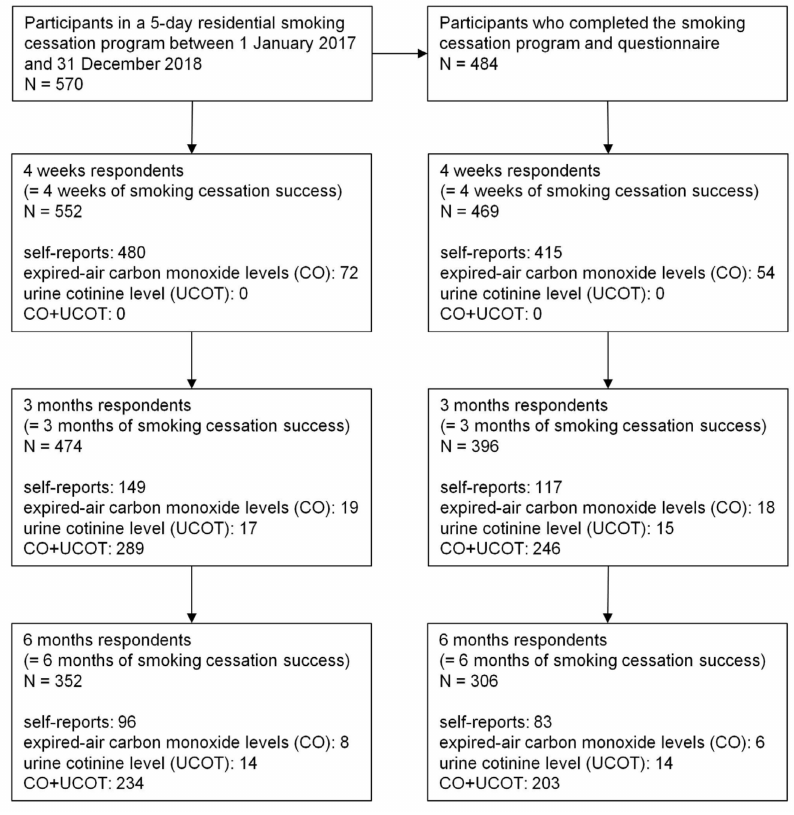
Figure 1. Participants flow chart. Table 2. Four weeks, 3 months, and 6 months of smoking cessation success (intention-to-treat). 4 Weeks 3 Months Follow-Up